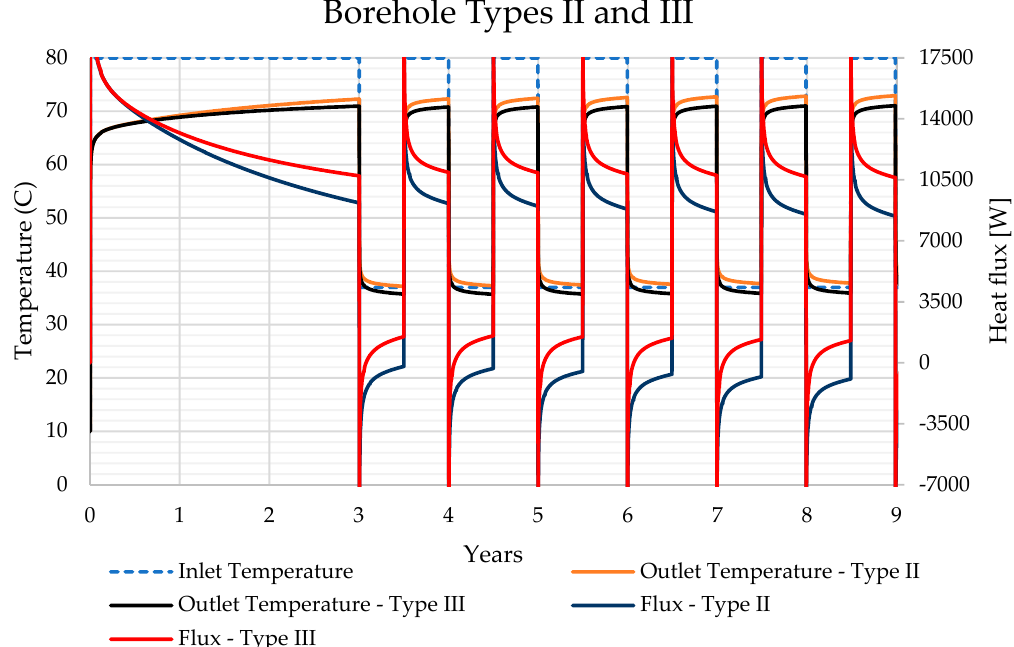
Figure 6. Ground thermal behavior showing three years of heat injection followed by six years of seasonal cyclic thermal storage and recovery process.